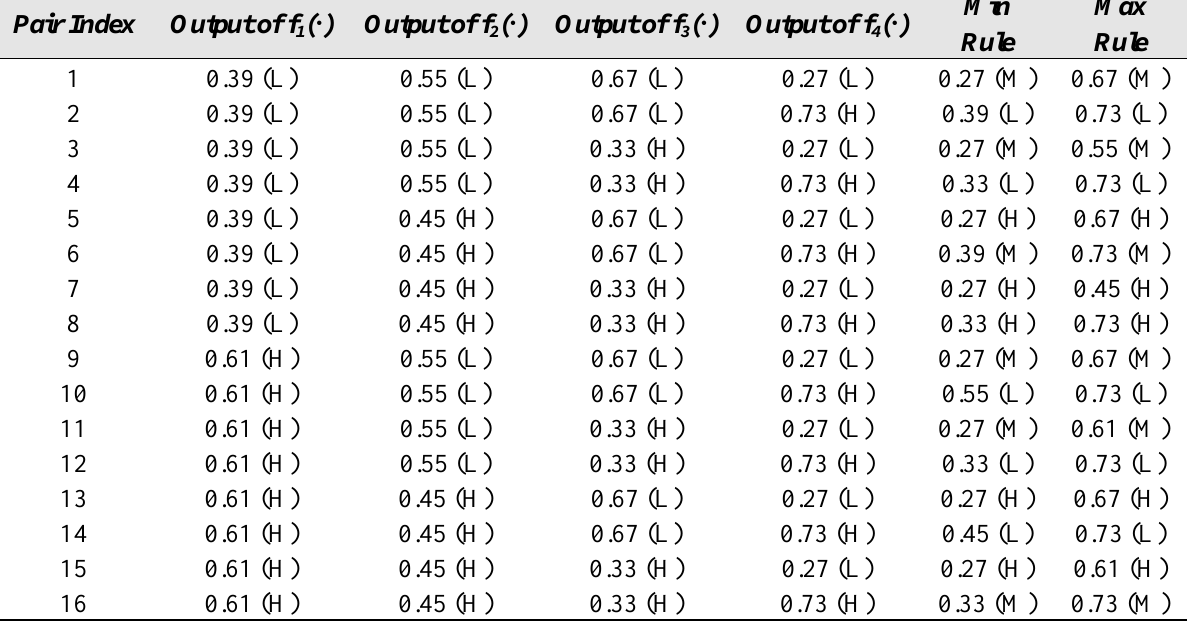
Table 3. Illustrations of 16 combination pairs of output values for four membership functions. Pair